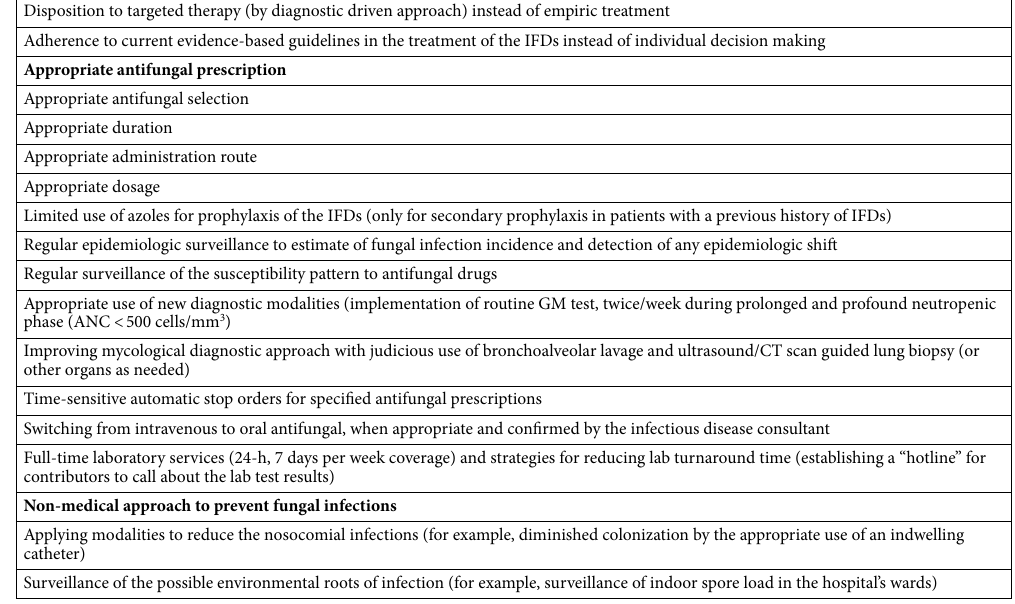
Table 1. Main components of AFS interventions for the management of invasive fungal diseases (including invasive candidiasis and invasive aspergillosis) in Amir medical oncology center. AFS antifungal Stewardship, IFDs invasive fungal diseases, IMDs invasive mold diseases, GM galactomannan, ANC absolute neutrophil count, AMOC Amir Medical Oncology